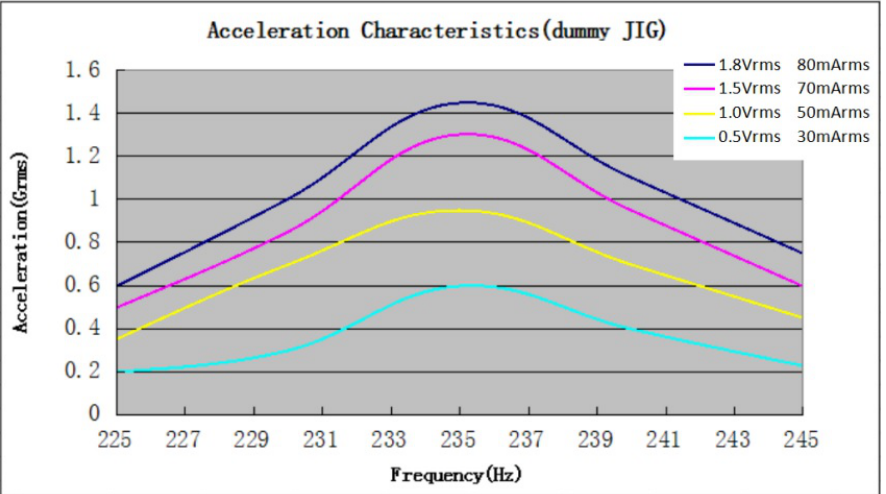
Figure 3. Linear vibrator frequency characteristics of the motors according to the manufacturer’s data sheet [61].